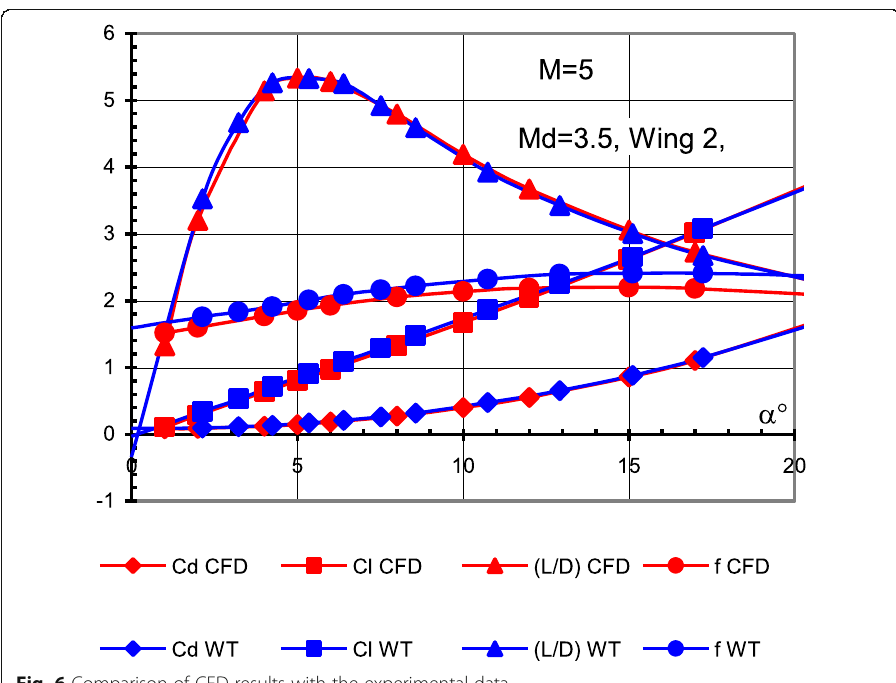
Fig. 6 Comparison of CFD results with the experimental